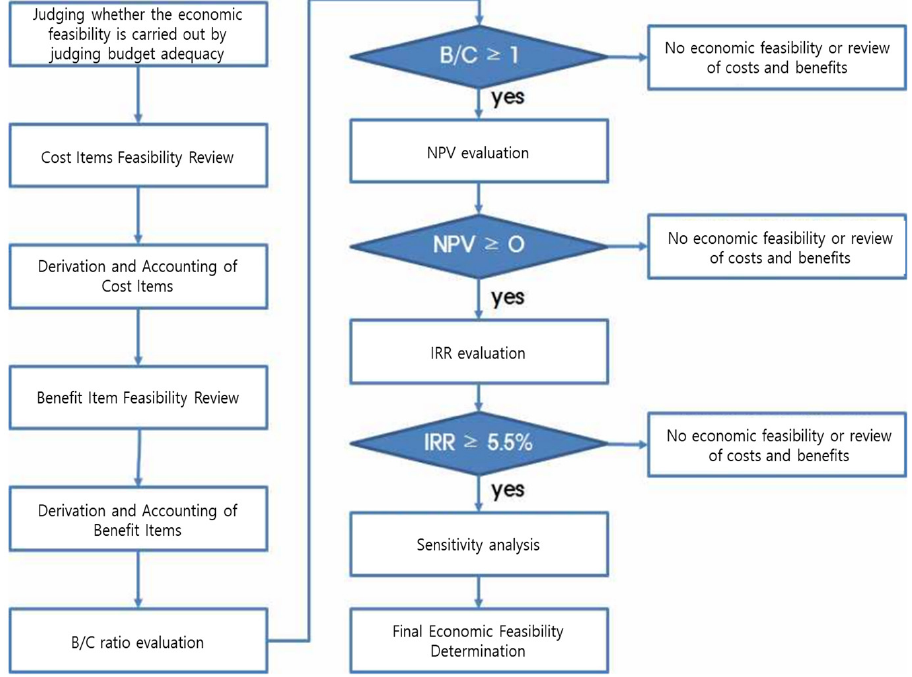
Figure 5. General economic feasibility procedure.